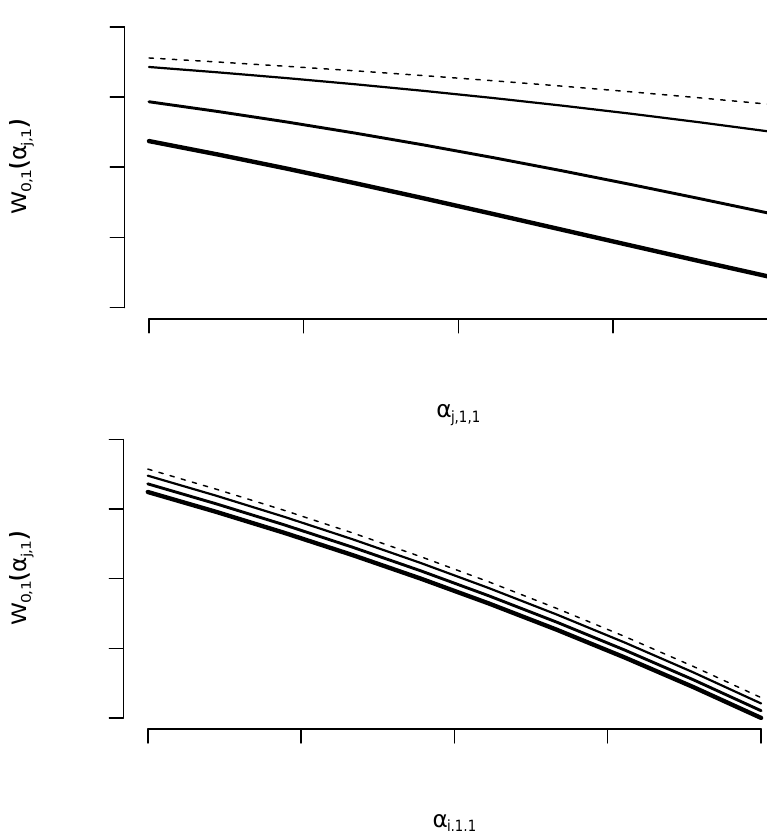
Figure 1. Shifts of the demand curves by increasing default risk ( top ) and capital costs ( bottom ). Top : the default risk probability p t = p changes from 0 (dashed) to 0.01, 0.05, 0.10 (solid lines, thicker with increasing p ). Bottom : capital cost p.a. r changes from 1% (dashed) to 5%, 10%, 15% (solid lines, thicker with increasing r ) for σ F = 0.1. Both plots: the x -axis shows α j ,1,1 , the buyer’s position in the put option on the rainfall in Changde during May ( CR May ,1 ) with strike K = 100 and investment horizon T = 1; the y -axis shows W 0,1 ( α j ,1 ) , the price our representative buyer is willing to pay for such an option, where α j ,1 = ( α j ,1,1 , α j ,1,2 ) (cid:62) and while α j ,1,2 , the position in the other put option on the rainfall in Enshi during May ( CR May ,2 ) is kept